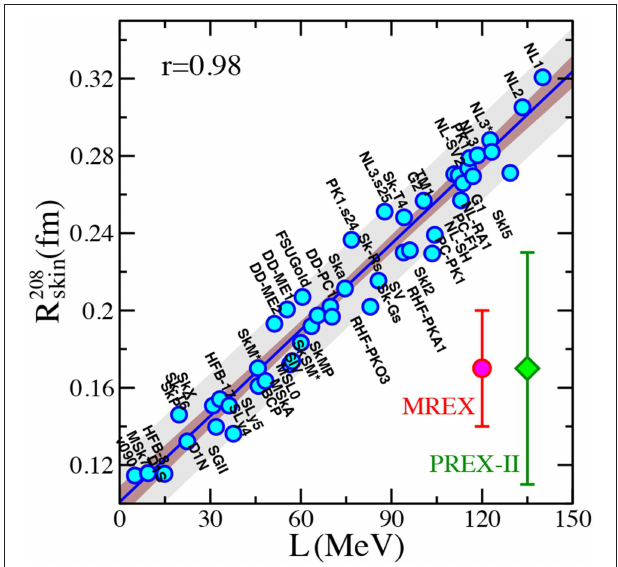
FIGURE 9 | Correlation between the slope parameter (L) and the neutron skin thickness of 208 Pb obtained with RMF models. The error bars represent the target precision for the future PREX-II [ 121] and MREX [150] experiments. Reproduced from Physics Today 72 , 7, 30 (2019) (https://doi.org/10.1063/PT. 3.4247) with the permission of the American Institute of